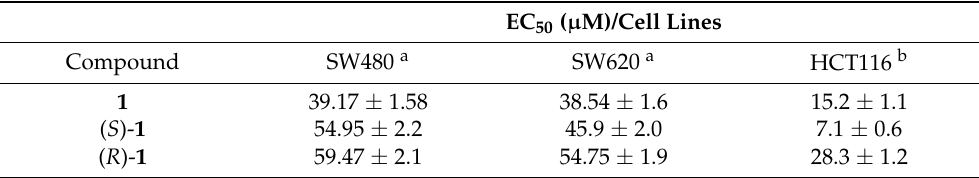
Figure 5. Confocal immunofluorescence showing the recruitment of DVL1-GFP (green) by HA-FZD4 (red) at the PM of HEK293 cells in the presence of 7 µ M of compound 1 (racemic mixture), ( S )- 1 , ( R )- 1 or the corresponding volume of vehicle (DMSO). (Magnification bar = to 14 µ m). Table 2. Growth Inhibition of SW680, SW620 and HCT116 Human Colon Carcinoma Cell Lines by Racemate 1 and Enantiomers ( S )- 1 and ( R )- 1